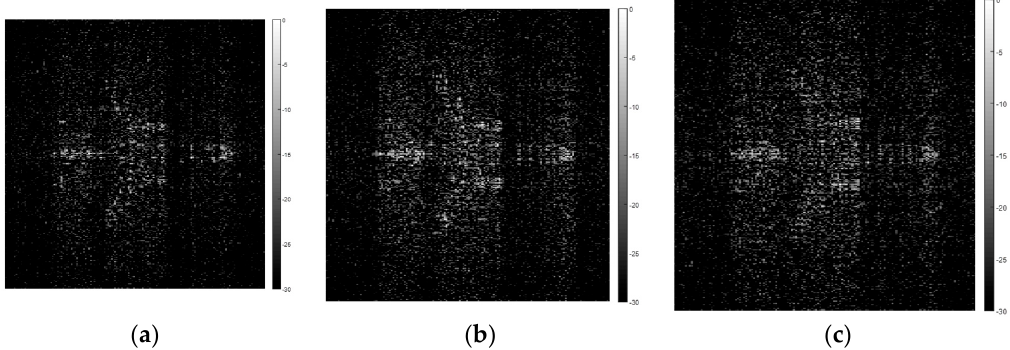
Figure 12. Effects of WBNI suppression for range-azimuth imaging based on the DDSE algorithm under different sparsity levels. ( a ) K = 174; ( b ) K = 348; and ( c ) K = 696.